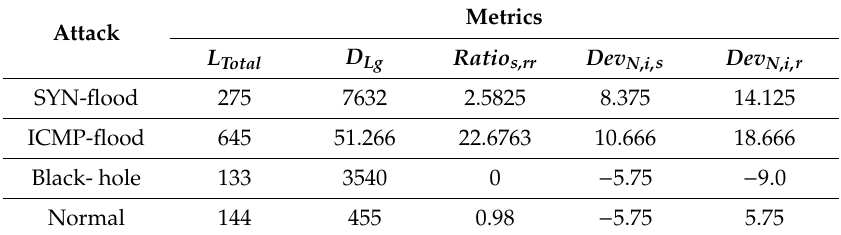
Table 4. Additional research findings on metric changes for attacks and normal